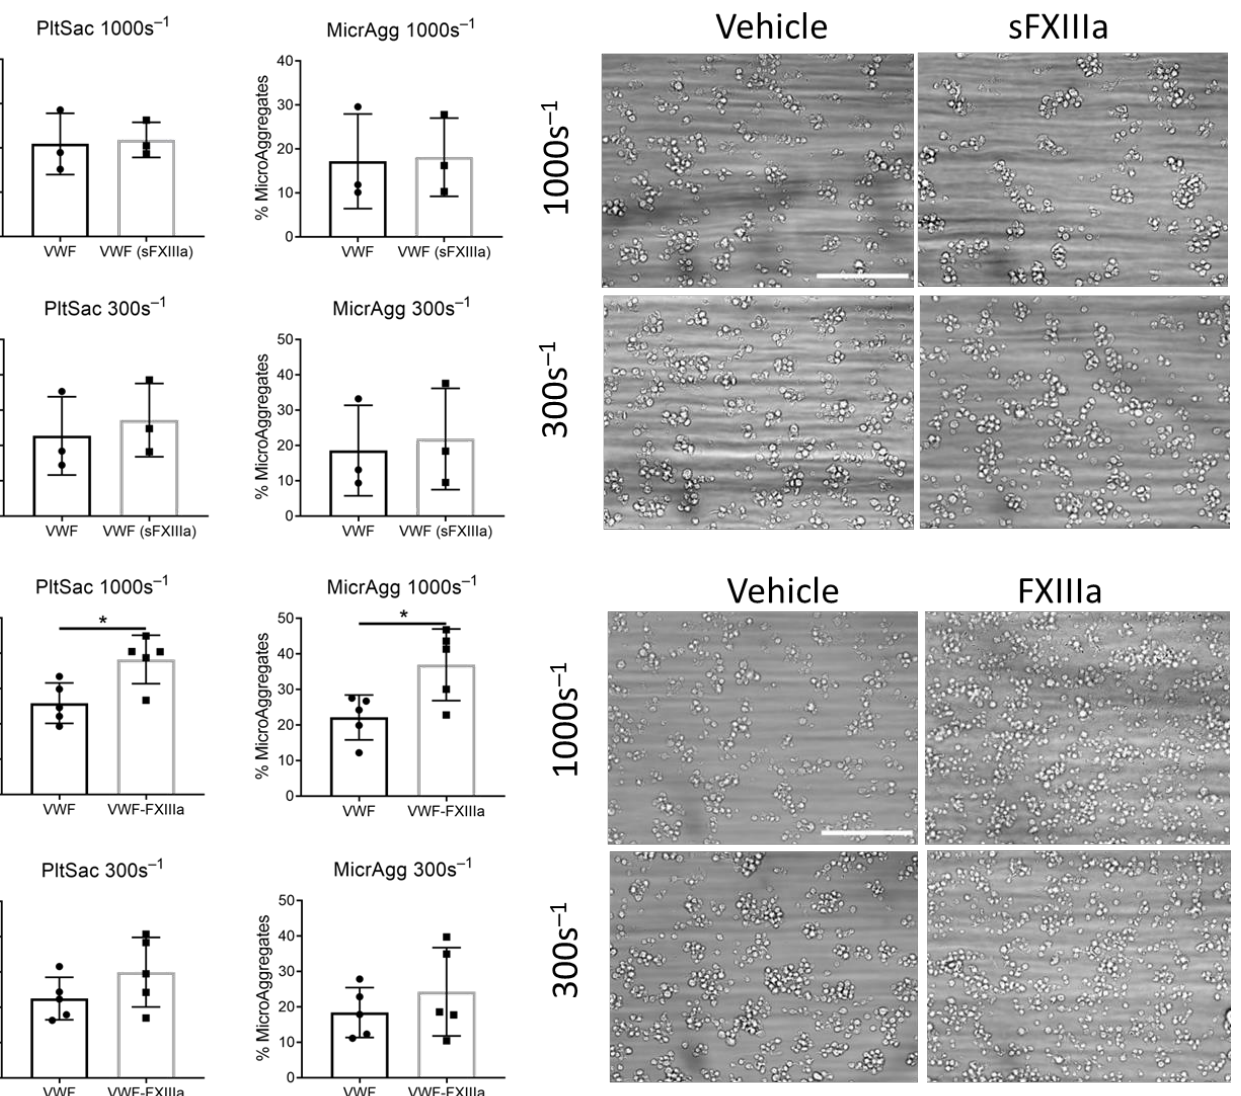
Figure 6. Immobilized FXIIIa enhances platelet adhesion and aggregate formation on VWF. ( A ) Blood samples were preincubated for 5 min with FXIIIa (10 U/mL) and perfused over a surface coated with VWF. ( B ) Blood samples were perfused over surfaces coated with VWF ± FXIIIa. Wall shear rate was 300 s − 1 or 1000 s − 1 . Representative brightfield images (bars, 40 µ m). Platelet adhesion (expressed as percentage surface area coverage, % PltSac). Platelets forming (micro)aggregates (expressed as percentage microaggregates, %MicrAgg). Unpaired t -test, * p < 0.05, mean ± SD, n = 3 – 5.